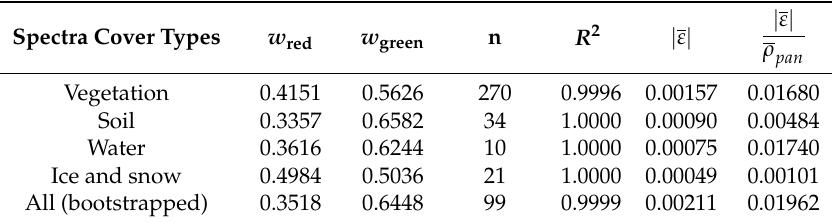
Table 2. As Table 1 but for the Landsat 8 red and green band spectral response function based (SRFB) spectral weights ( w red and w green ) derived as Equation